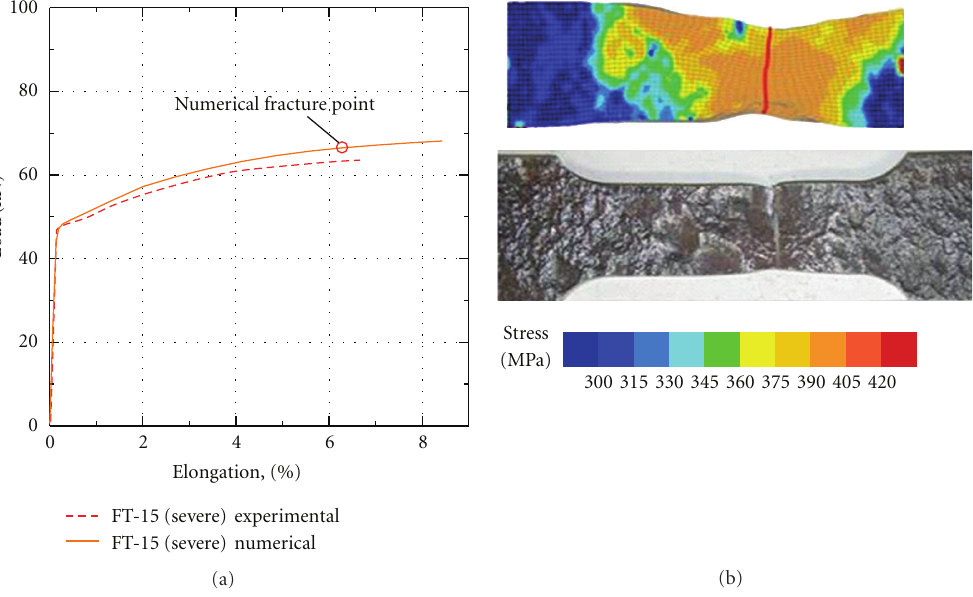
Figure 7: (a) Comparison of experimental and analytical load-elongation curves and (b) stress distribution at ultimate load for the severe corrosion member [FT-15].